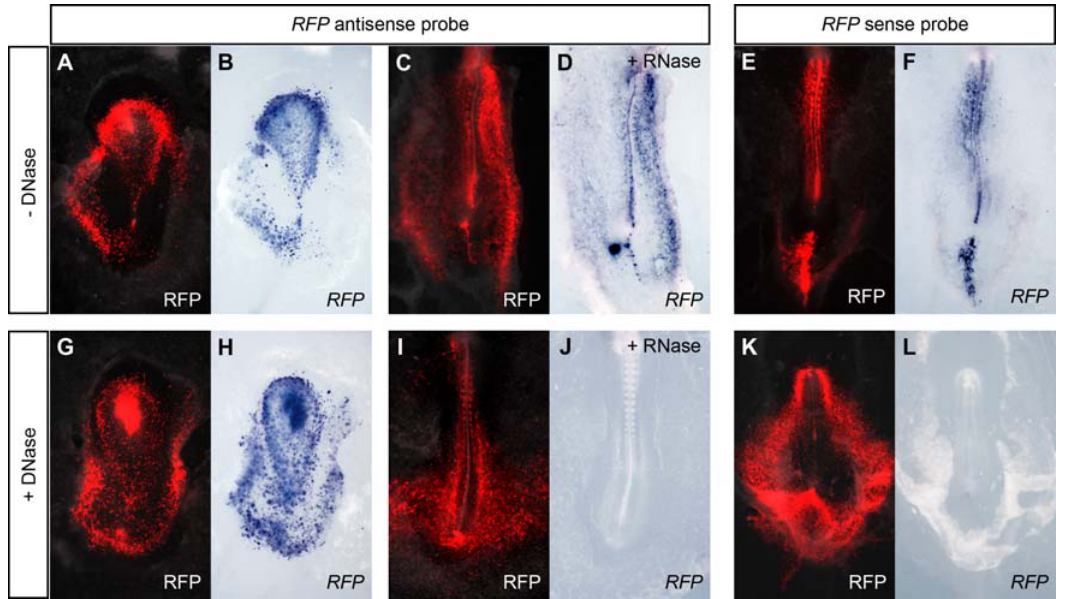
Figure 1. Comparison between RFP fluorescence and RFP expression patterns in CAGGS-RFP electroporated chick embryos. Chick embryos were electroporated with the ubiquitous reporter construct pCAGGS-RFP and processed for WISH. (A, C, E, G, I, K) Merge of bright field with RFP fluorescence images. (B, D, F, H, J, L) Detection of RFP antisense and sense probes by WISH. RFP antisense probe was detected in all RFP- fluorescent cells of embryos processed by conventional WISH (A, B). A similar co-localization was observed in embryos either treated with RNase A prior to hybridization (D) or hybridized with the RFP sense probe (F). When embryos were treated with DNase I, the antisense probe was also detected in the RFP -expressing cell population (H), but not in RNase A-treated embryos (J), and the sense probe was undetectable